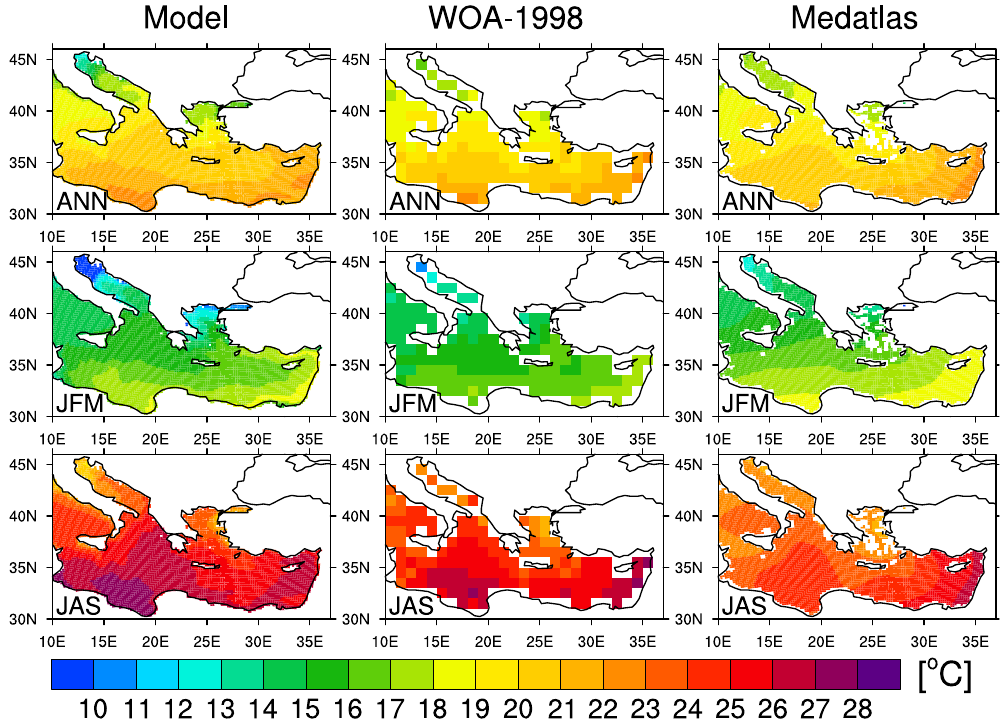
Fig. 5. Annual, winter (JFM) and summer (JAS) SSTs at 6m depth for CTRL (left), World Ocean Atlas 1998 climatology (middle) and MEDATLAS climatology